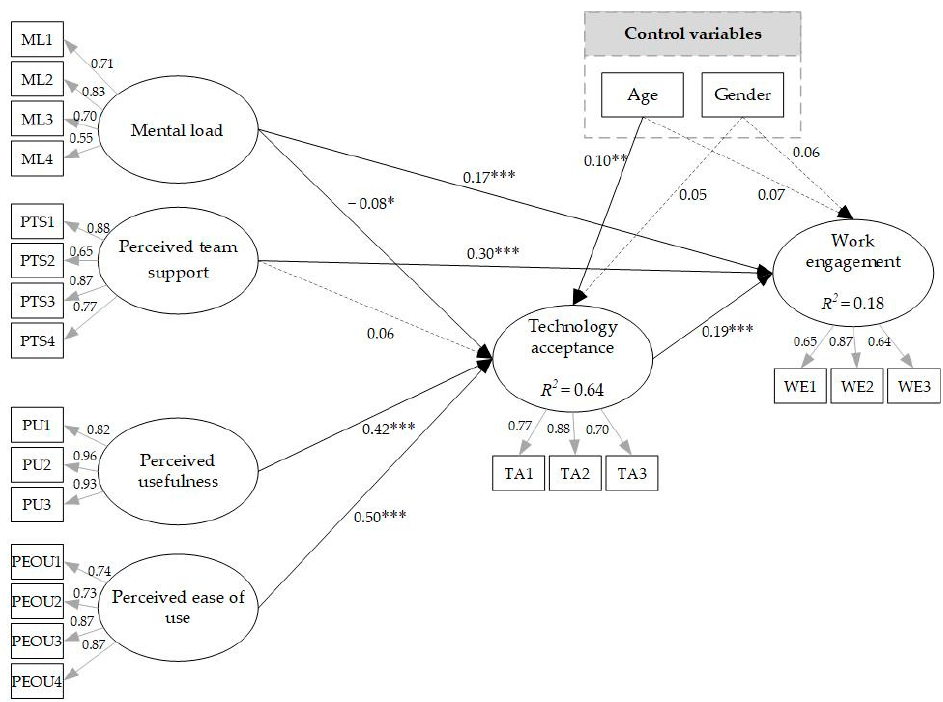
Figure 2. The final model. Note: Discontinuous lines mean nonsignificant relationships. *** p < 0.001; ** p < 0.01; * p < 0.05.